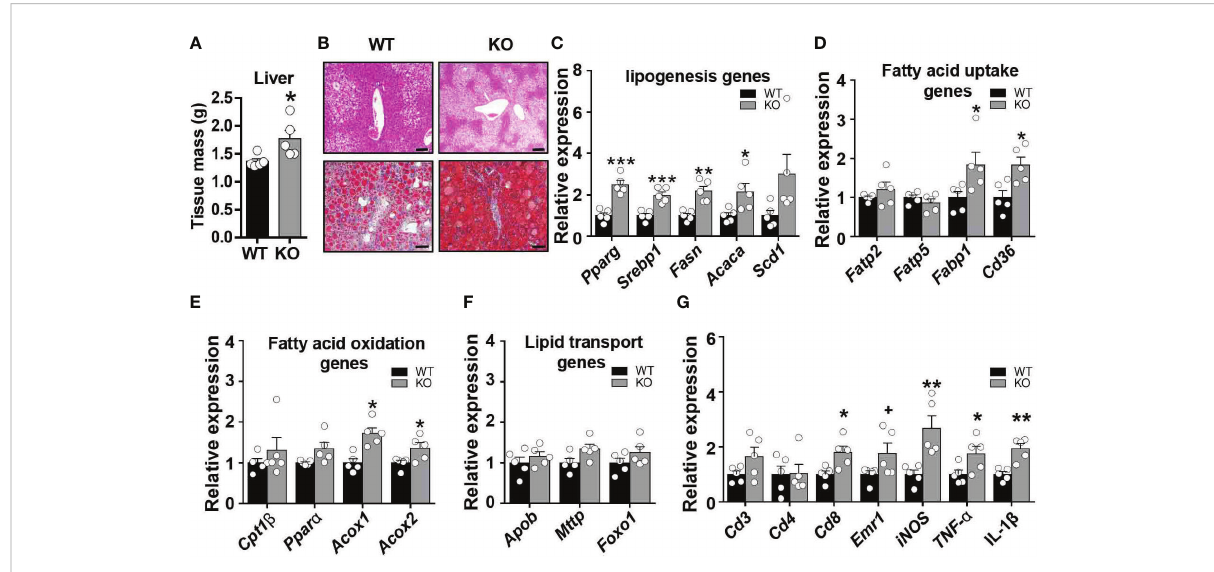
FIGURE 5 CCL5 de fi ciency promotes HFD-induced lipid accumulation in liver. (A) Weight of liver from WT and CCL5 KO mice after 16 weeks HFD. (n = 5 mice per group). (B) Representative H&E (Scale bar: 100 m m) and Oil red O (Scale bar: 50 m m) stained section of liver from WT and CCL5 KO mice after 16 weeks HFD. (C) mRNA expression of lipogenesis genes in liver from WT and CCL5 KO mice after 16 weeks HFD. (n = 5 mice per group). (D) mRNA expression of fatty acid uptake genes in liver from WT and CCL5 KO mice after 16 weeks HFD. (n = 5 mice per group). (E) mRNA expression offatty acid oxidation genes in liver from WT and CCL5 KO mice after 16 weeks HFD. (n = 5 mice per group). (F) mRNA expression of lipid transport genes in liver from WT and CCL5 KO mice after 16 weeks HFD. (n = 5 mice per group). (G) mRNA expression of immune cell markers and cytokines in the liver from WT and CCL5 KO mice after 16 weeks HFD. (n = 5 mice per group). Data are mean ± s.e.m. + p <0.1, * p <0.05, ** p <0.01, *** p <0.001 by unpaired Student ’ s